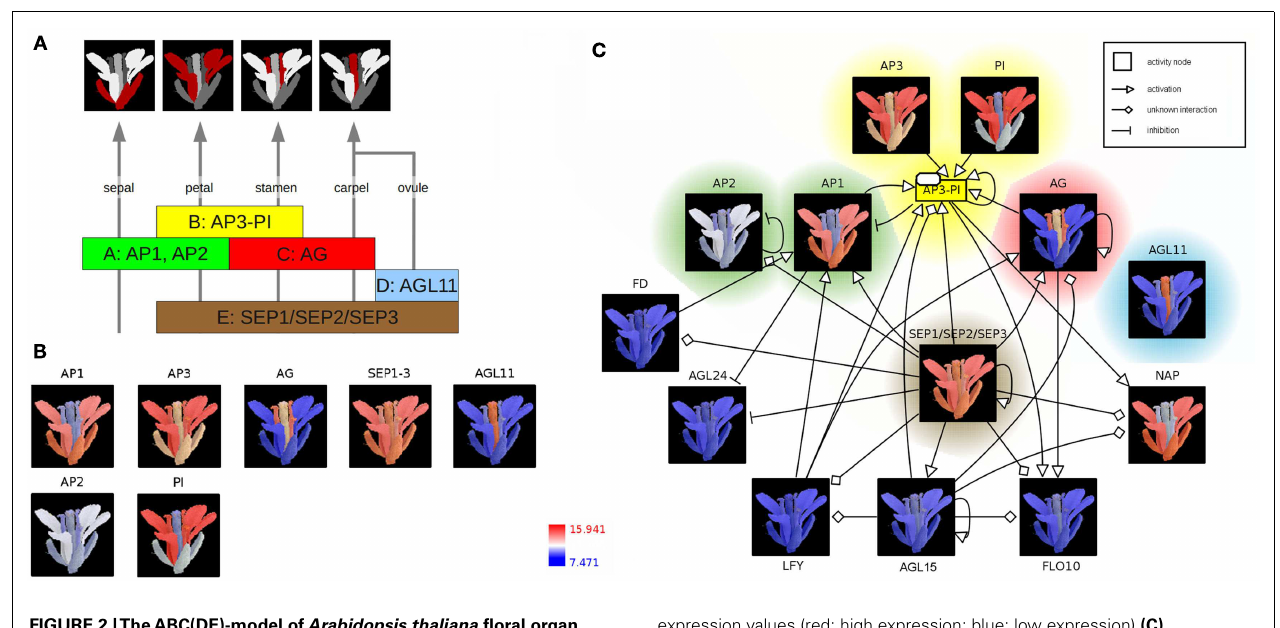
FIGURE 2 |TheABC(DE)-model of Arabidopsis thaliana floral organ specification. (A) Determination of floral organ identity depends on the combinatorial expression of floral homeotic genes from different classes. (B) Color-coding of an A. thaliana flower image based on